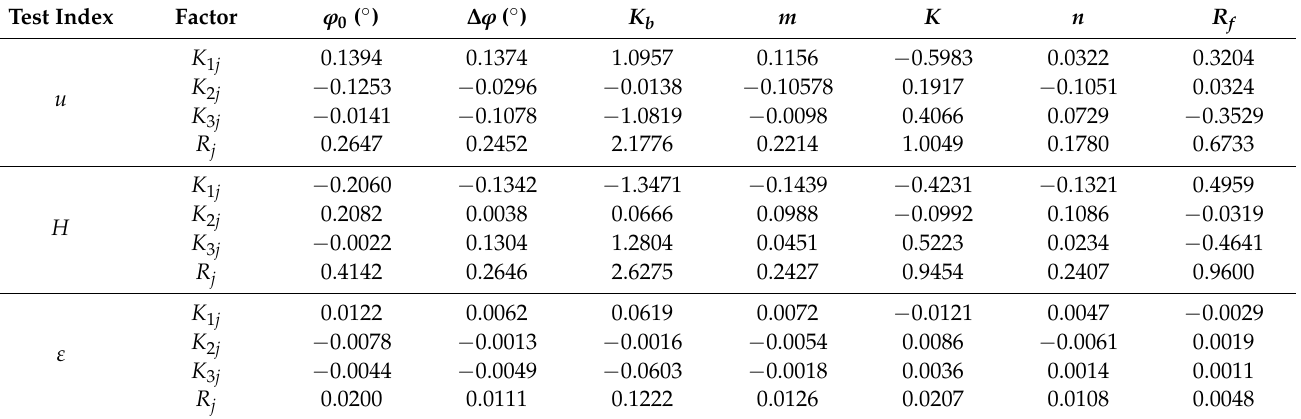
Table 9. Range analysis results of influencing factors on each test index for the secondary rockfill zone.